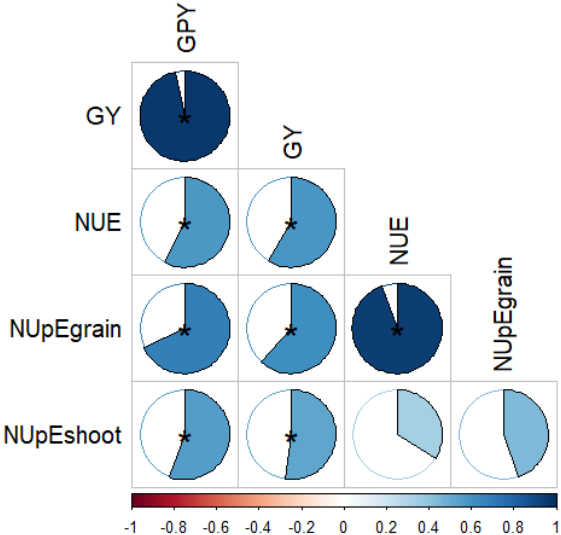
Figure 7. Correlation coefficients of different N-use efficiency indices with grain yield and grain protein yield. The shaded circle area shows the absolute value of the corresponding correlation coefficients. All the relationships were positive. An asterisk (*) indicates the significance at p < 0.01. GY, grain yield; GPY, grain protein yield; NUpE shoot , Shoot N uptake efficiency; NUE, N-use efficiency; NUpE grain , grain N uptake efficiency.